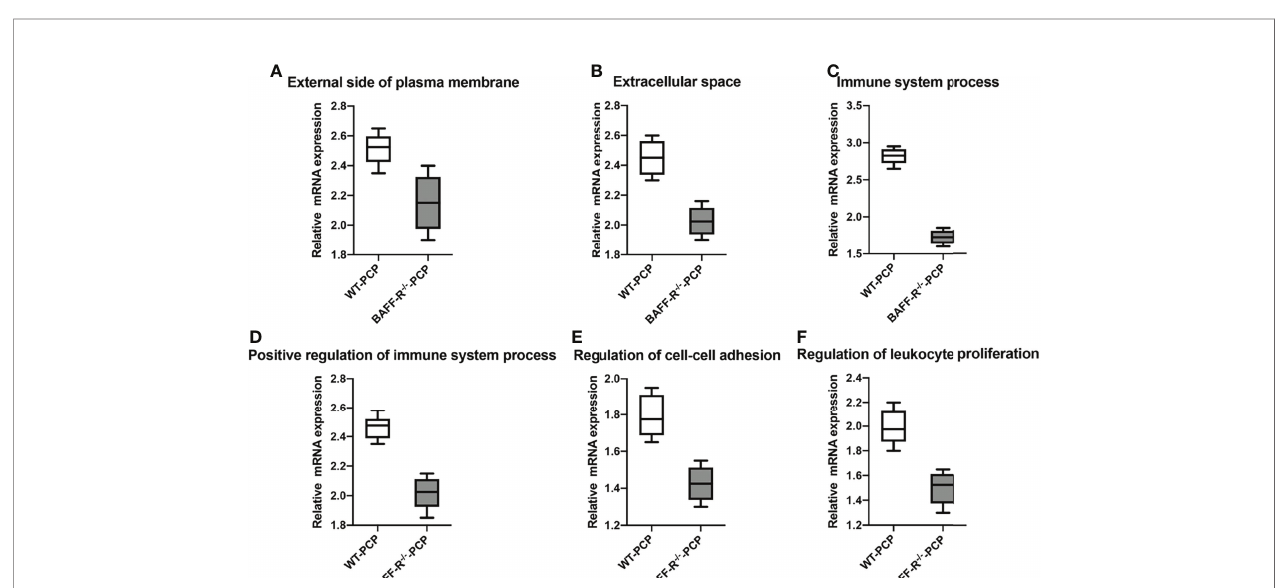
FIGURE 9 | Box-and-whisker plots of the relative mRNA expression values in the BAFF-R – / – PCP mice compared with the WT-PCP mice. The genes included were related to the respective pathways including the external side of plasma membrane (A) , extracellular space (B) , immune system process (C) , a positive regulation of the immune system process (D) , regulation of cell – cell adhesion (E) , and regulation of leukocyte proliferation (F) . All P <